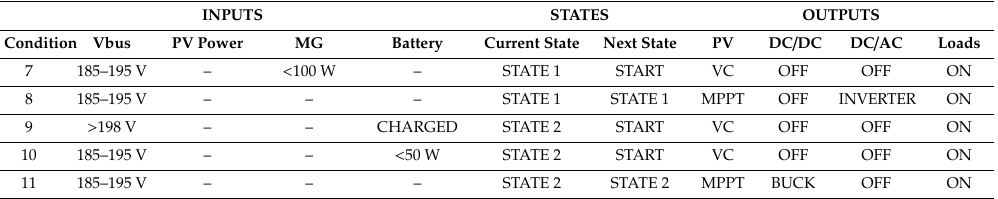
Table 4. GMC transitions in STATE 1 and 2.